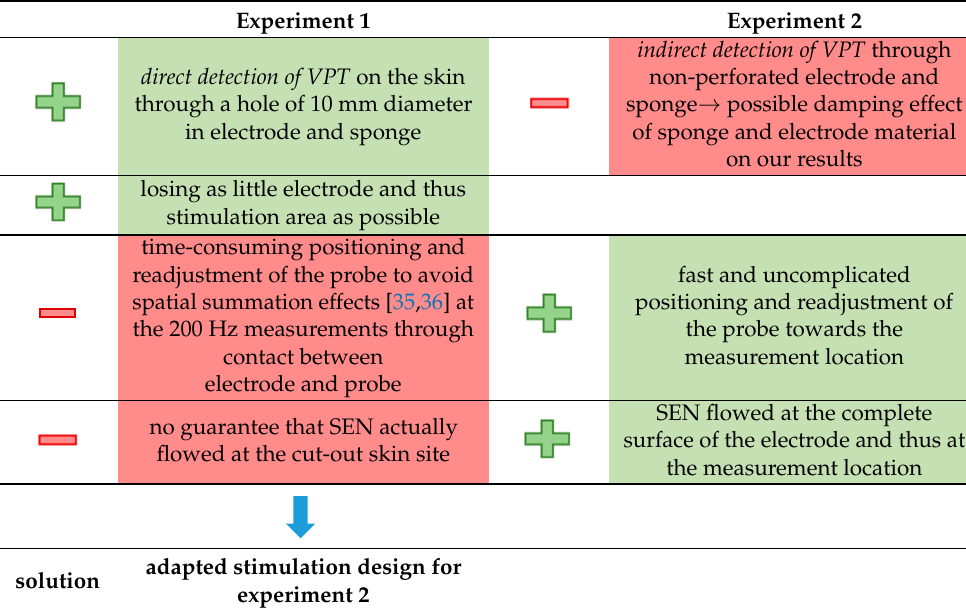
Table 3. Defining characteristics and their advantages (green) and disadvantages (red), differentiated by experiment. SEN: subliminal electrical noise stimulation.